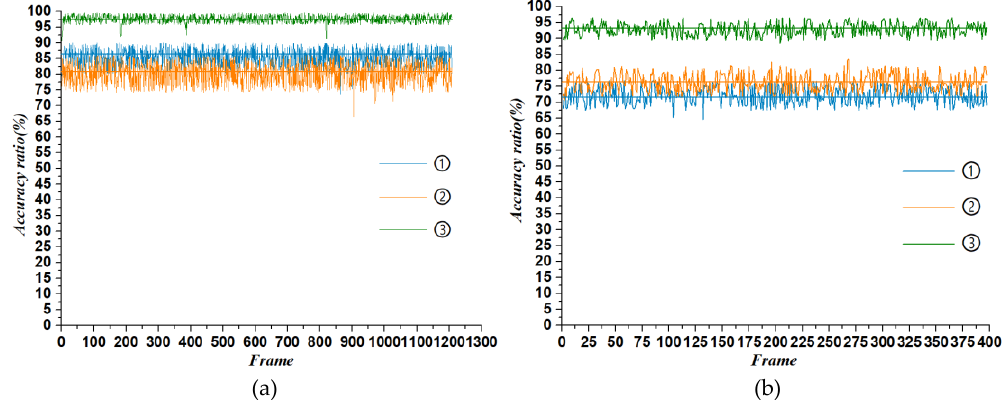
Figure 9. The accuracy ratio of different methods. ( a ) represents the accuracy ratio of the straight line road, and ( b ) represents the accuracy ratio of the curved road. In the figure: ① is the high difference extraction method, ② is the point cloud density extraction method, and ③ is the application method of this paper.